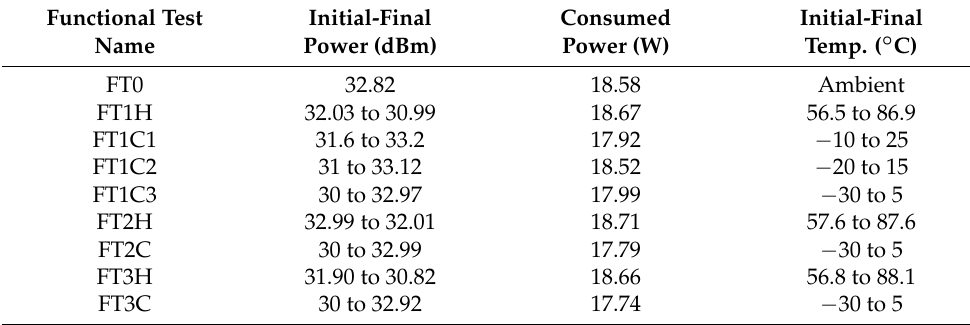
Figure 5. Dependency of the EDFA’s output optical power with wavelength for different levels of input optical power. Table 1. Numerical results of the EDFA’s full TVT